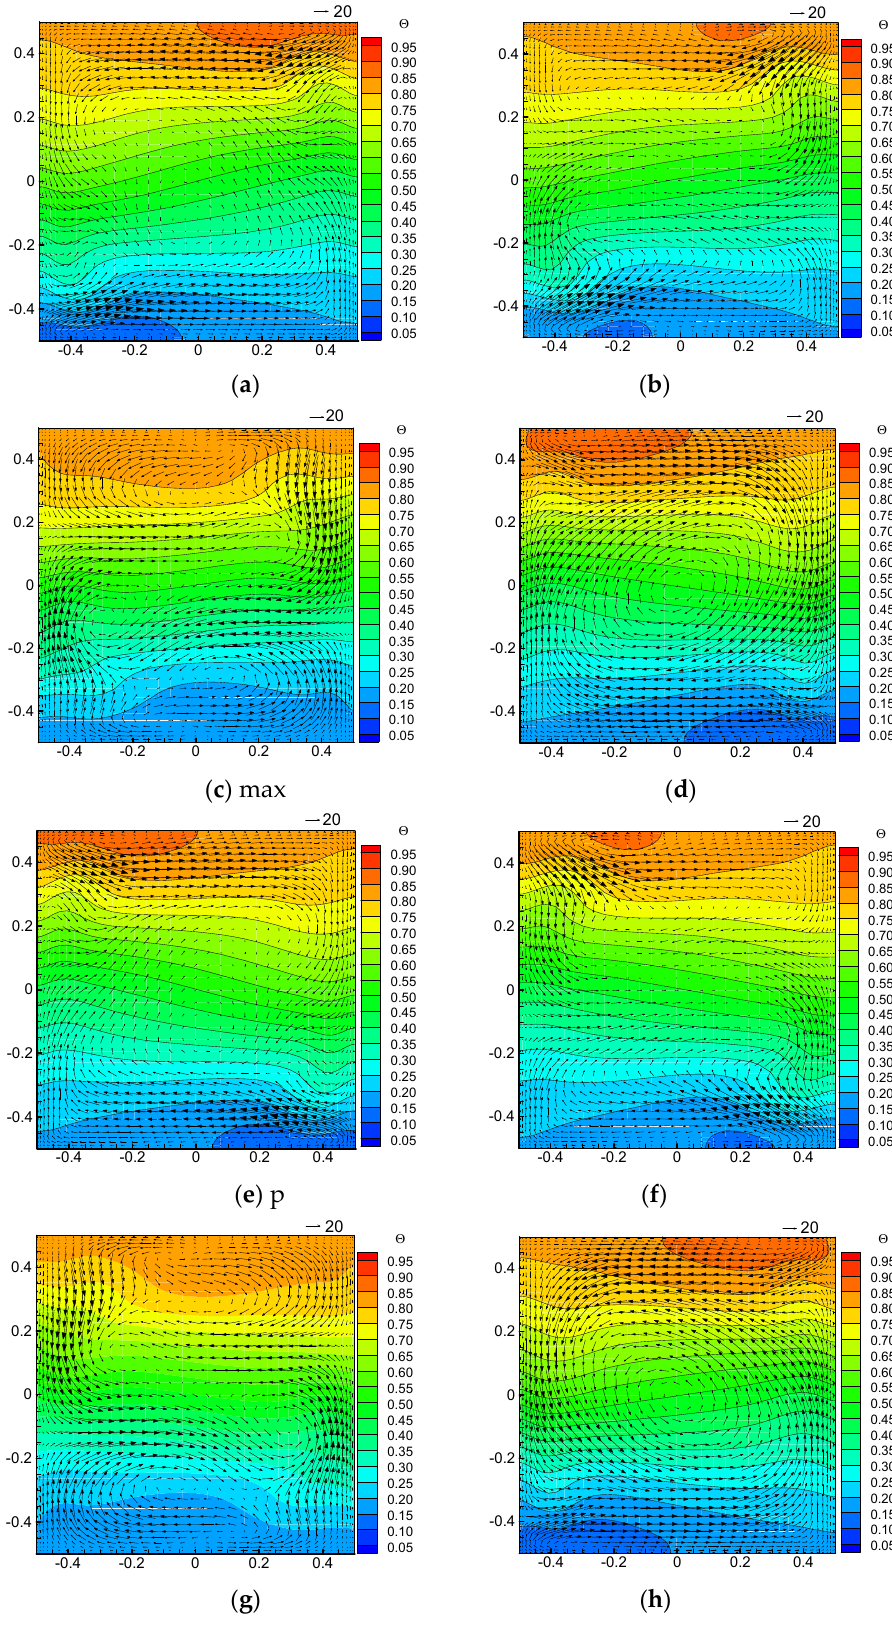
Figure 13. Temperature field evolution at x-o-z plane for Case 4: ( a ) ϕ = 0 (+) ; ( b ) ϕ = ϕ m /2 (+)